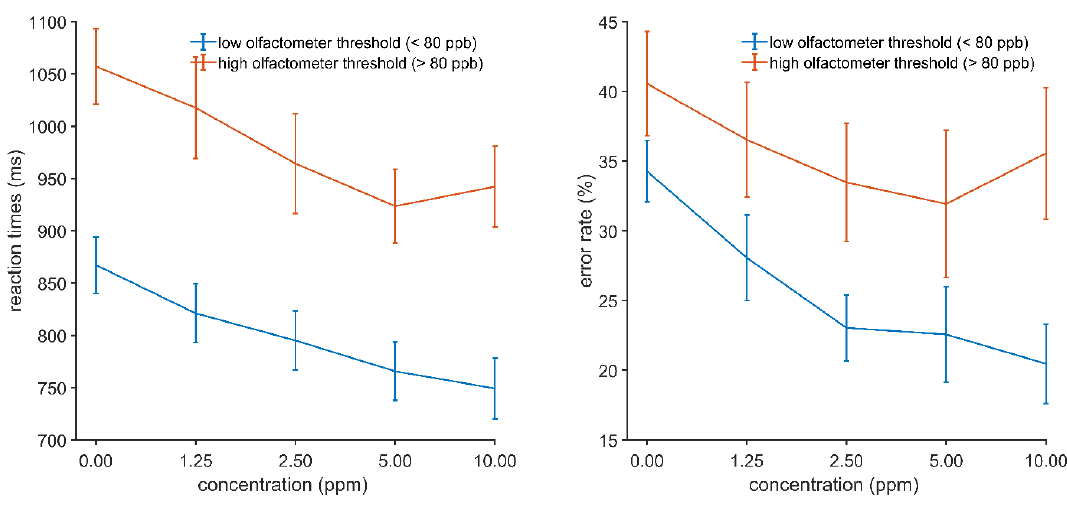
Figure 6. E ff ect of olfactometer-based threshold on 3-back reaction times ( left ) and error rates ( right ) during ammonia exposure (mean ± SEM).